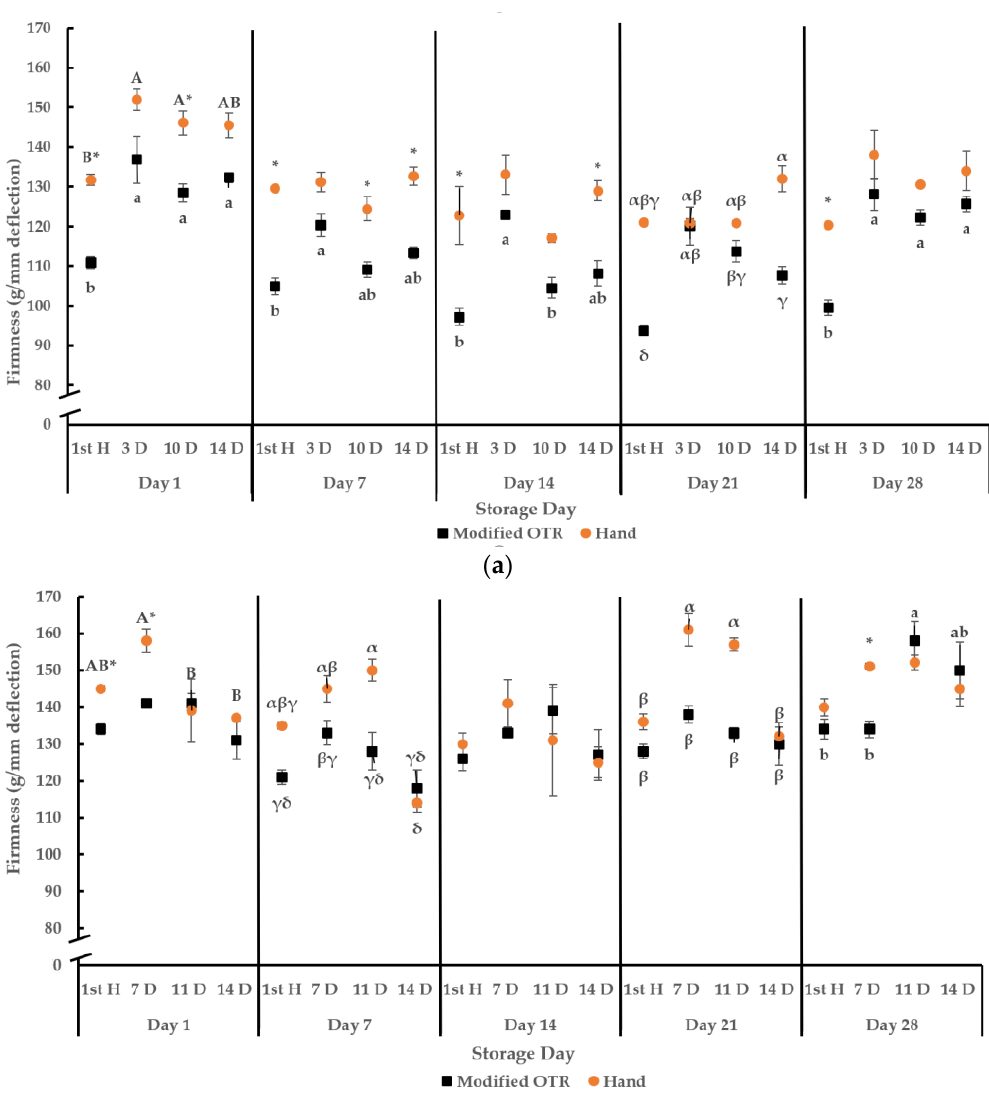
Figure 3. Firmness of ‘Liberty’ northern highbush blueberry in 2019 ( a ) and 2020 ( b ) at 1, 7, 14, 21, and 28 days after packing. Fruits were harvested at 3-, 10-, and 14-day harvest intervals in 2019 and at 7-, 11-, and 14-day harvest intervals in 2020. The first harvest was the baseline from which interval treatments were established. Fruits were harvested by hand or using a modified over-the-row (OTR) harvester with patent-pending elastomeric polymers installed on catching surfaces in northwest Washington, USA. Values are mean ± SE ( N = 3). Different uppercase letters indicate significant differences ( p < 0.05) within hand-harvested fruits on each evaluation day due to harvest interval effects. Different lowercase letters indicate significant differences ( p < 0.05) within machine-harvested fruits on each evaluation day due to harvest interval effects. * indicates significant differences ( p < 0.05) within the same harvest interval on each evaluation day due to harvest method effect. Different Greek letters indicate significant differences ( p < 0.05) among both hand- and machine-harvested fruit on each evaluation day due to interaction effects of harvest method and interval.